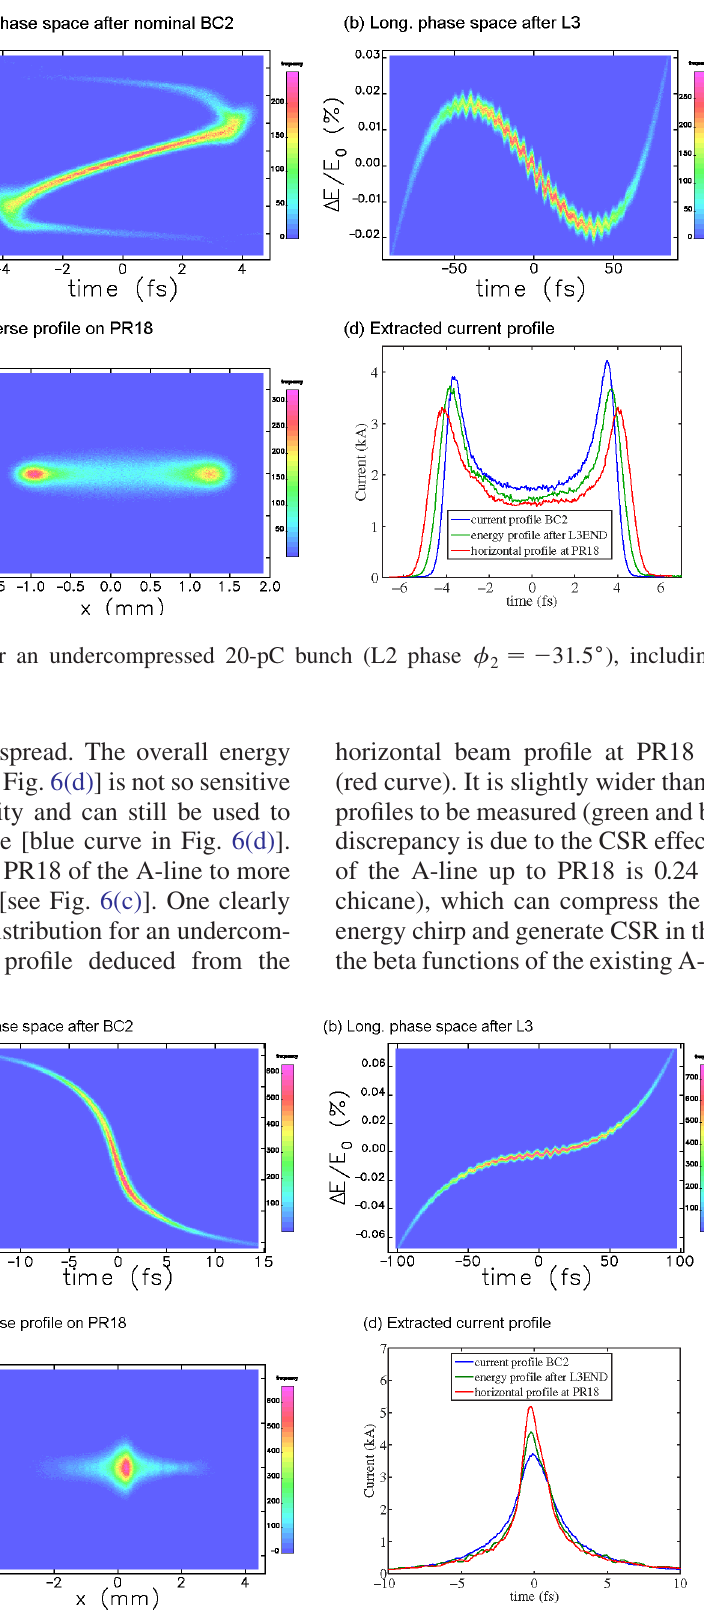
FIG. 7. ELEGANT simulation for an overcompressed bunch (L2 phase (cid:7) 2 ¼ (cid:2) 33 (cid:10) ), including CSR effects in bends, wakefield, and LSC in